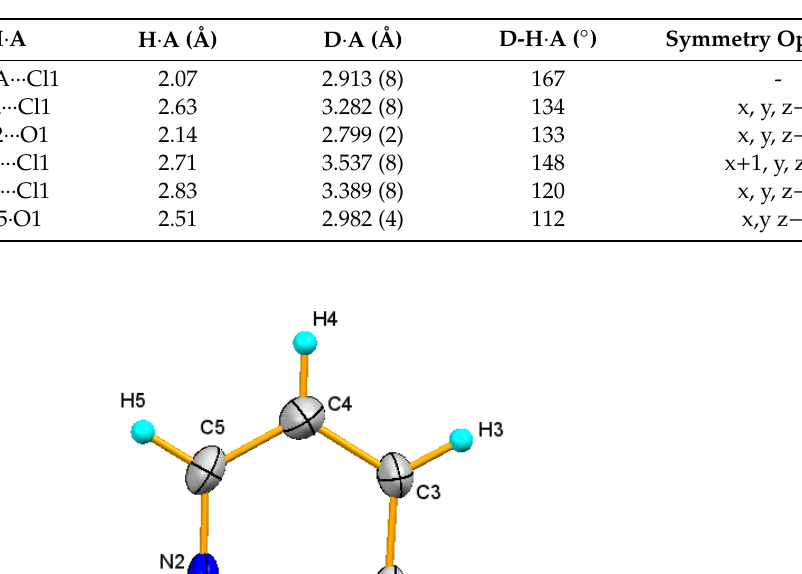
Table 2. Hydrogen bonds parameters for (C 6 H 7 N 2 O) + · Cl − .